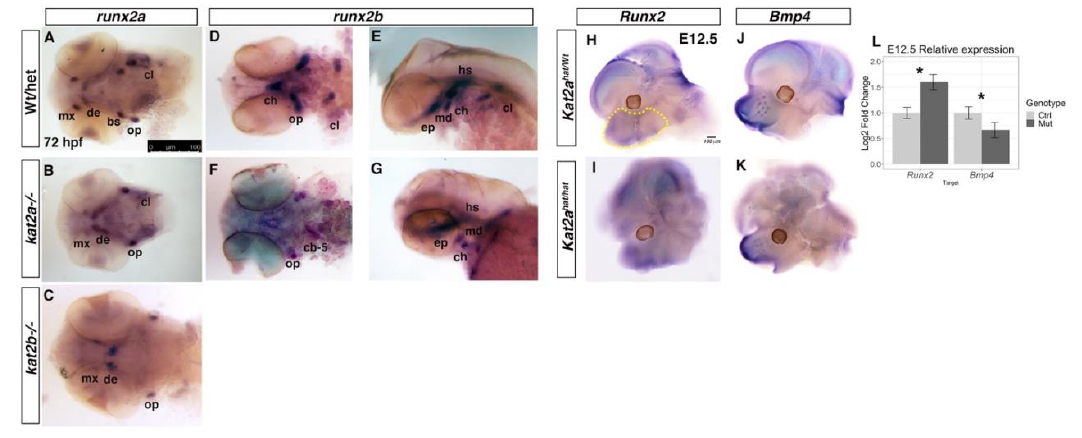
Figure 4. The bone progenitor markers runx2a and runx2b are differentially expressed in kat2a − / − and kat2b − / − zebrafish embryos and Kat2a hat/hat mouse embryos. In situ hybridization for runx2a ( A – C ) and runx2b ( D – G ) in WT or heterozygous ( A , D , E ), kat2a − / − ( B , F , G ), and ( C ) kat2b − / − 72 hpf zebrafish embryos. ( A – D , F ) ventral views, ( E , G ) lateral views, with the anterior to the left in all. kat2a − / − ( B ) and kat2b − / − ( C ) show reduced expression of runx2a , especially in the anterior maxilla, whereas expression in the dentary bone remains strong as compared to controls ( A ). runx2b expression in forming bone elements is reduced overall in kat2a mutants ( F , G ) compared to the control ( D , E ). For runx2a , n = 9/34 for kat2a , n = 8/31 for kat2b . For runx2b , n = 8/30 for kat2a , n = 8/29 for kat2b . ( H – L ) Whole-mount in situ hybridization with Runx2 and Bmp4 antisense probes on mouse E12.5 Kat2a Wt/hat ( H , J ) and Kat2a hat/hat ( I , K ) embryos. ( L ) RT-qPCR quantification of Runx2 and Bmp4 expression with RNA extracted from E12.5 facial prominences of control ( Kat2a Wt/hat ; Ctrl on graph) and mutant ( Kat2a hat/hat ; Mut on graph) embryos. The yellow outline in ( H ) marks the area dissected for RNA extraction. Gene expression was normalized to GusB, n = 4. The Y-axis shows the Log2 fold change of the relative gene expression, following the ddCT method; * denotes statistical significance ( p < 0.05) using Welch’s t -Test. The error bars show the standard error of the mean. Neural tube closure defects are evident in Kat2a hat/hat mutants. bs, branchiostegal ray; cb-5, ceratobranchial-5; ch, ceratohyal; cl, cleithrum; de, dentary; ep, ethmoid plate; hs, hyosymplectic; md, mandible; mx, maxilla; op, opercle. The scale bars represent 100 μm.